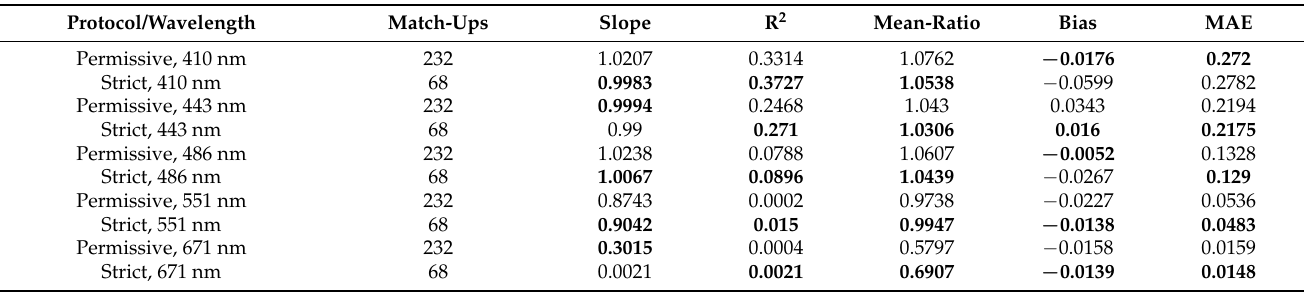
Table 10. MOBY data. Permissive versus strict, 5 × 5 statistical box. June 2014–May 2019. Values closest to one in bold, for slope, R 2 , and mean ratio. Lowest values in bold for bias and mean absolute